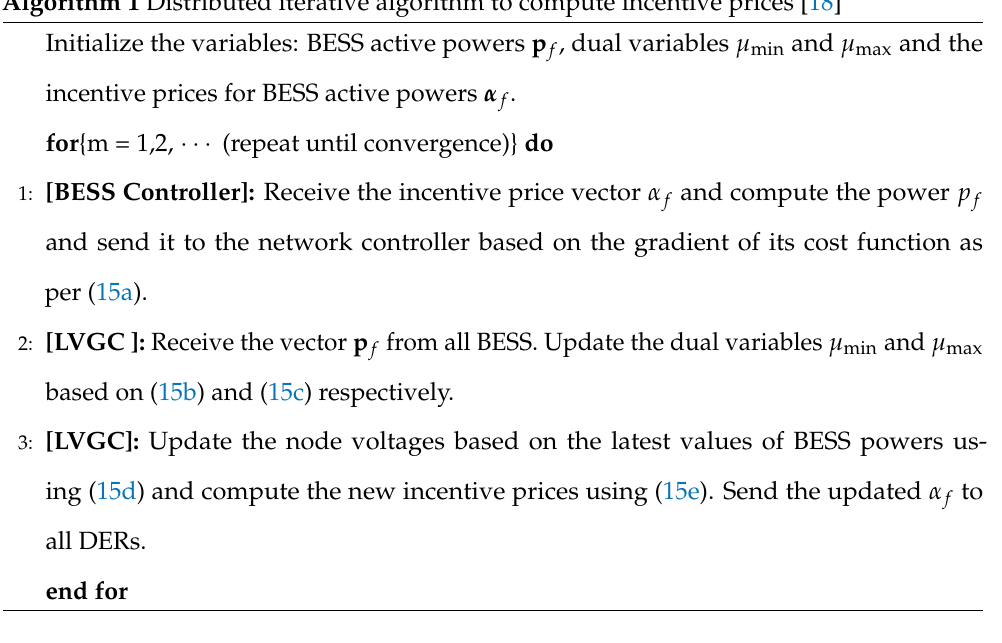
Algorithm 1 Distributed iterative algorithm to compute incentive prices